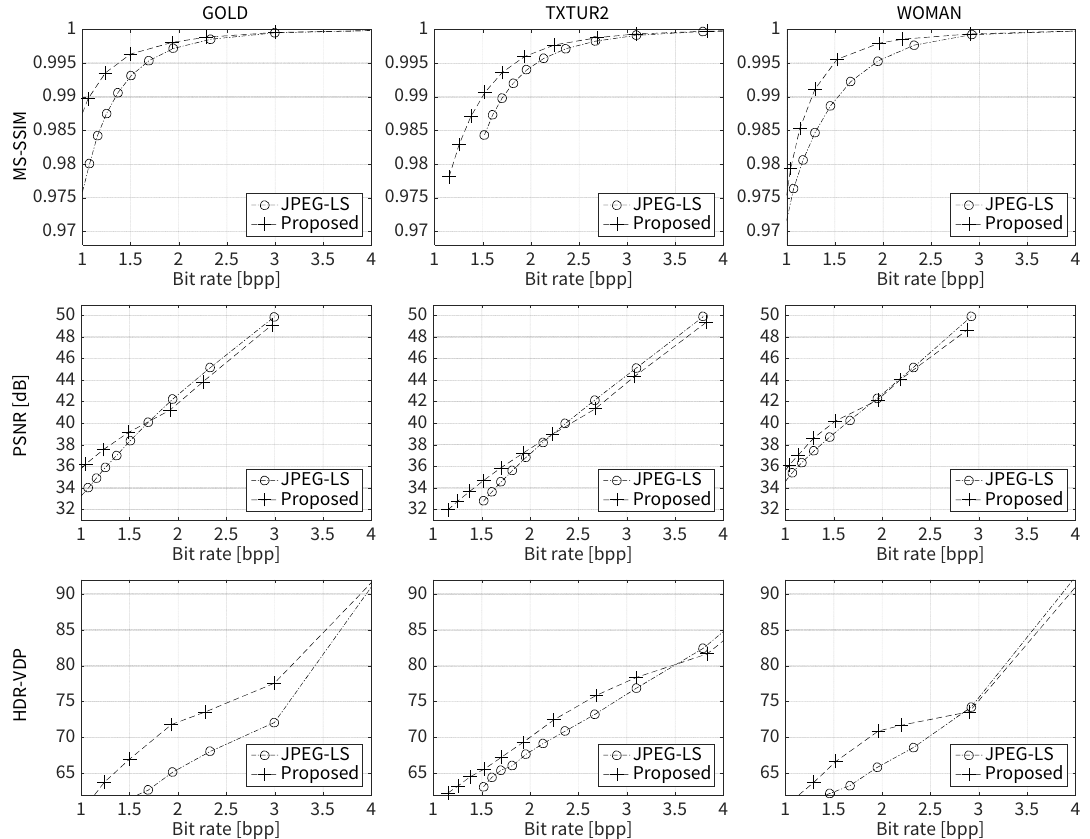
Figure 25. Objective rate-distortion plots of the proposed codec and JPEG-LS: top to bottom, MS-SSIM, PSNR and HDR-VDP values; and left to right, results for test images GOLD, TXTUR2 and